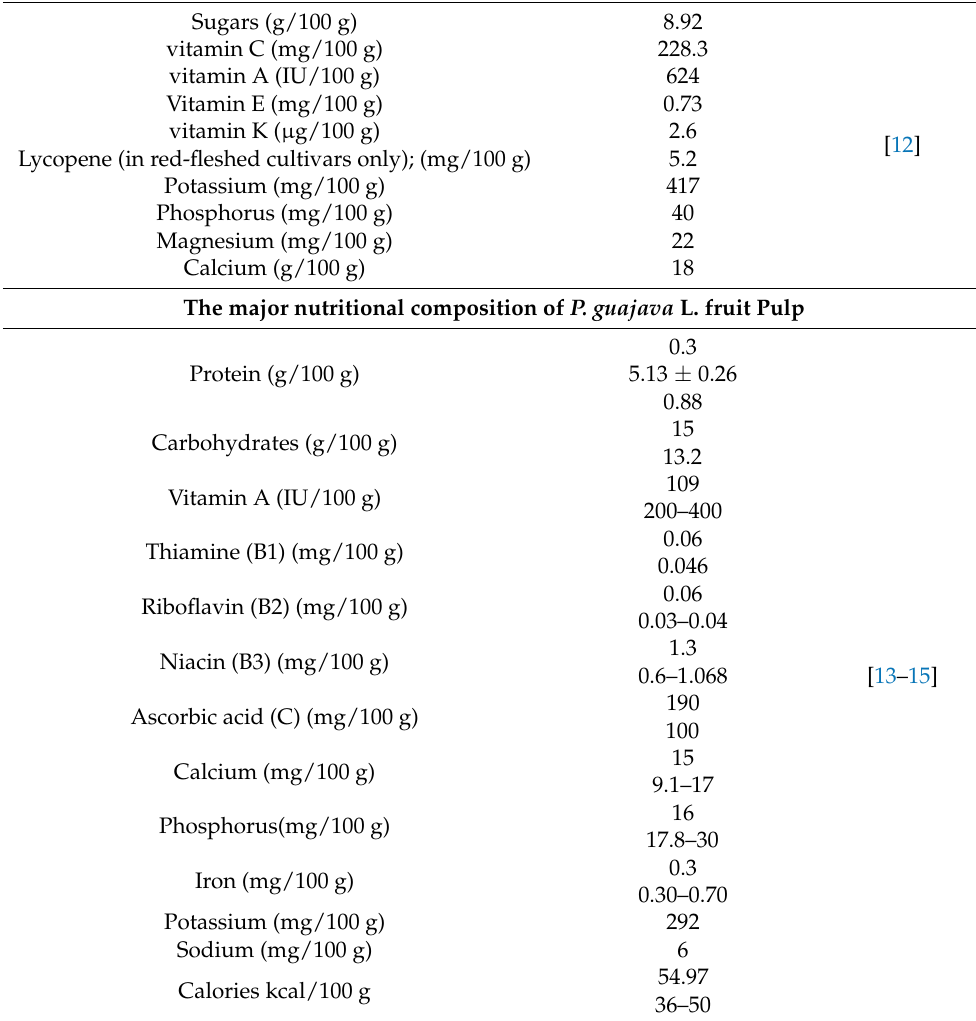
Table 1. Nutritional composition of different parts of P. guajava L. The Major Nutritional Composition of P. guajava L. Whole Fruit Nutritional